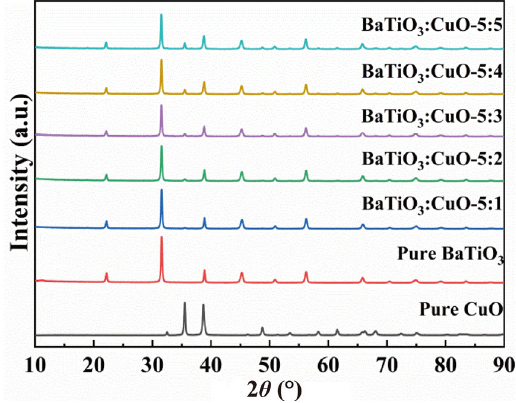
Fig. 1 XRD patterns of CuO NPs, BaTiO 3 NWs, and BaTiO 3 /CuO